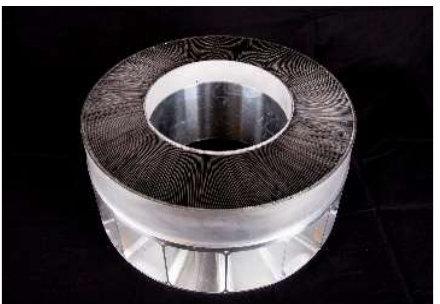
Fig. 2 . A photo of a prototype WAVES device for selection of the final wavelength of the neutrons scattered at the sample